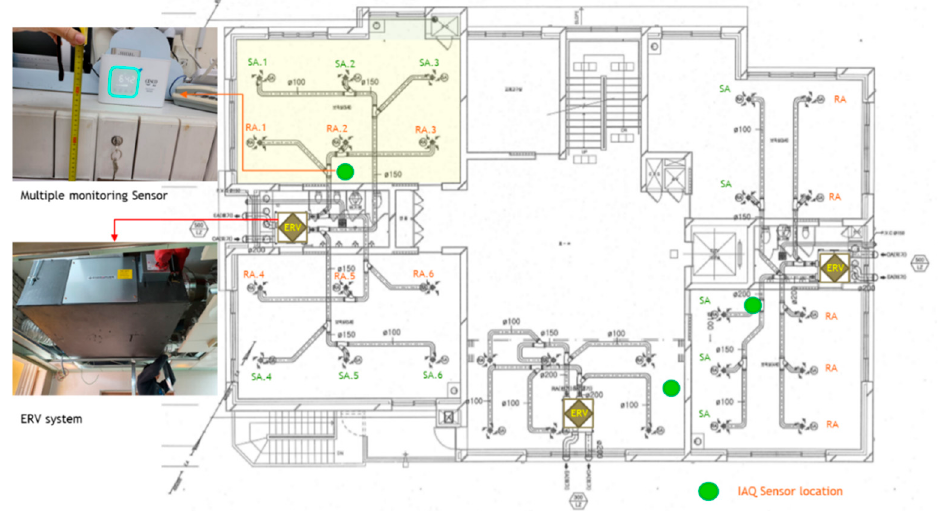
Figure 2. The 2nd floor plan of the childcare center along with the energy recovery ventilation (ERV) systems and the multiple monitoring sensors (the height of sensors is about 1.36 m above the floor). Table 1. Measurement range and accuracy of the multiple monitoring sensor.